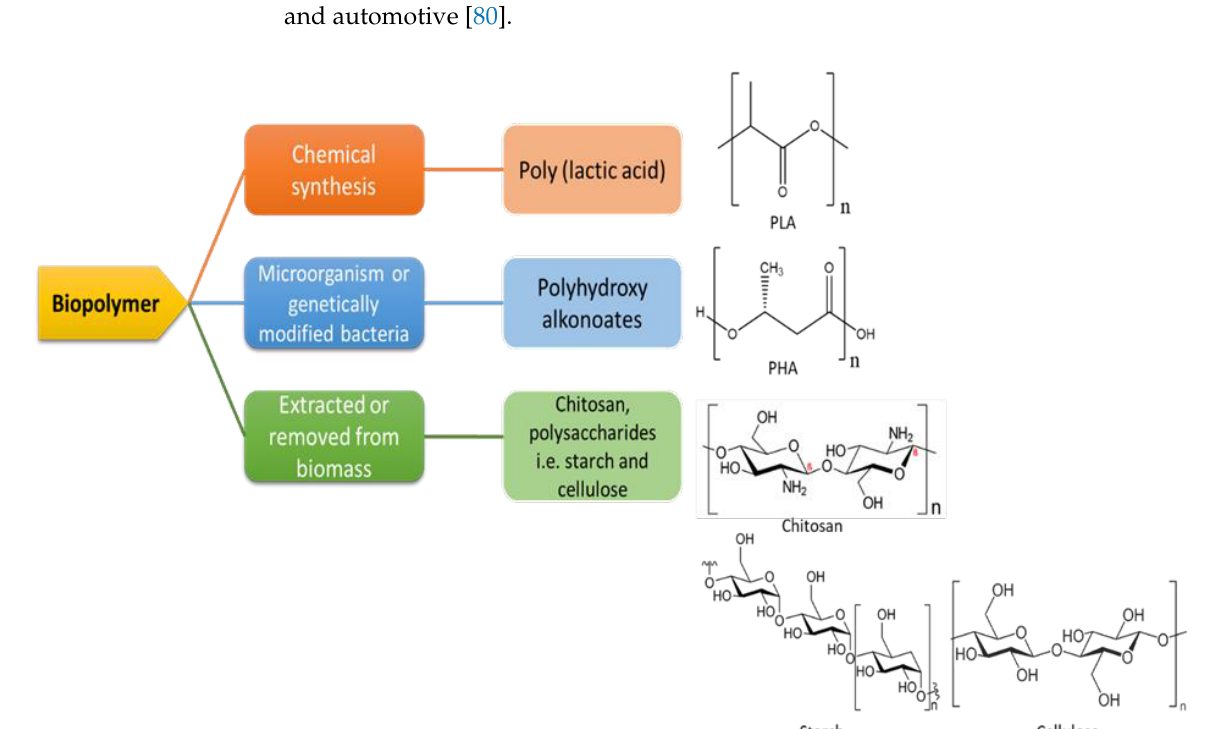
Figure 3. Chemical structure and classification of significant biopolymers based on their origin. Reproduced with copyright permission from Mohanty et al. [81].